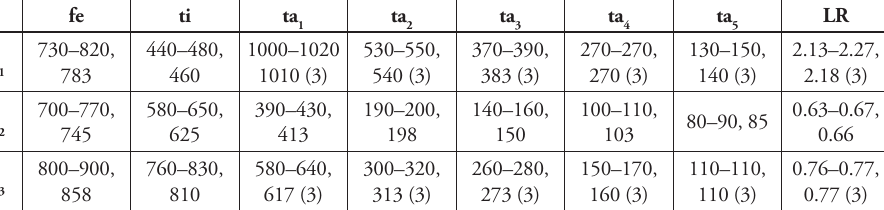
Table 1. Lengths (in µm) and proportions of adult male legs in H. parallela Yan & Wang, sp. n. (n=4). fe